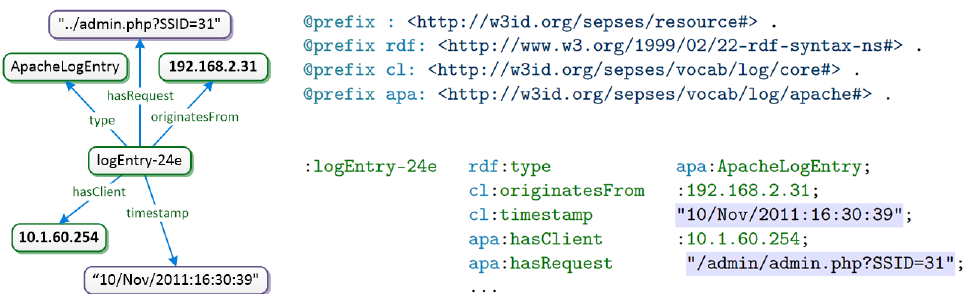
Figure 3. Excerpt of an RDF log graph generated from an Apache log